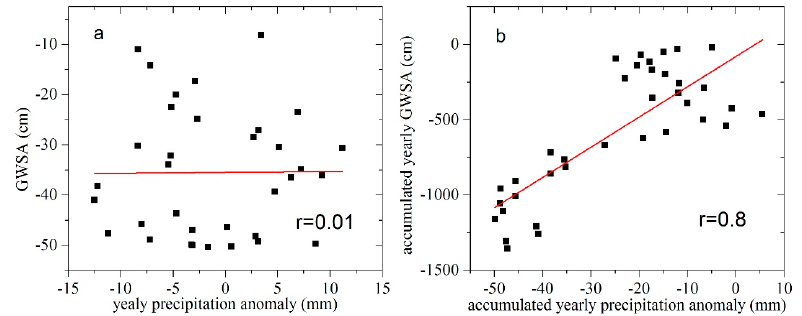
Figure 6. The relationship between precipitation and GWS anomaly (GWSA) as evaluated by the Pearson correlation coefficient at the 5% level. ( a ) the relationship between the precipitation anomaly and GWSA (r = 0.01, p > 0.05); ( b ) the relationship between accumulated precipitation anomaly and GWSA (r = 0.80, p <